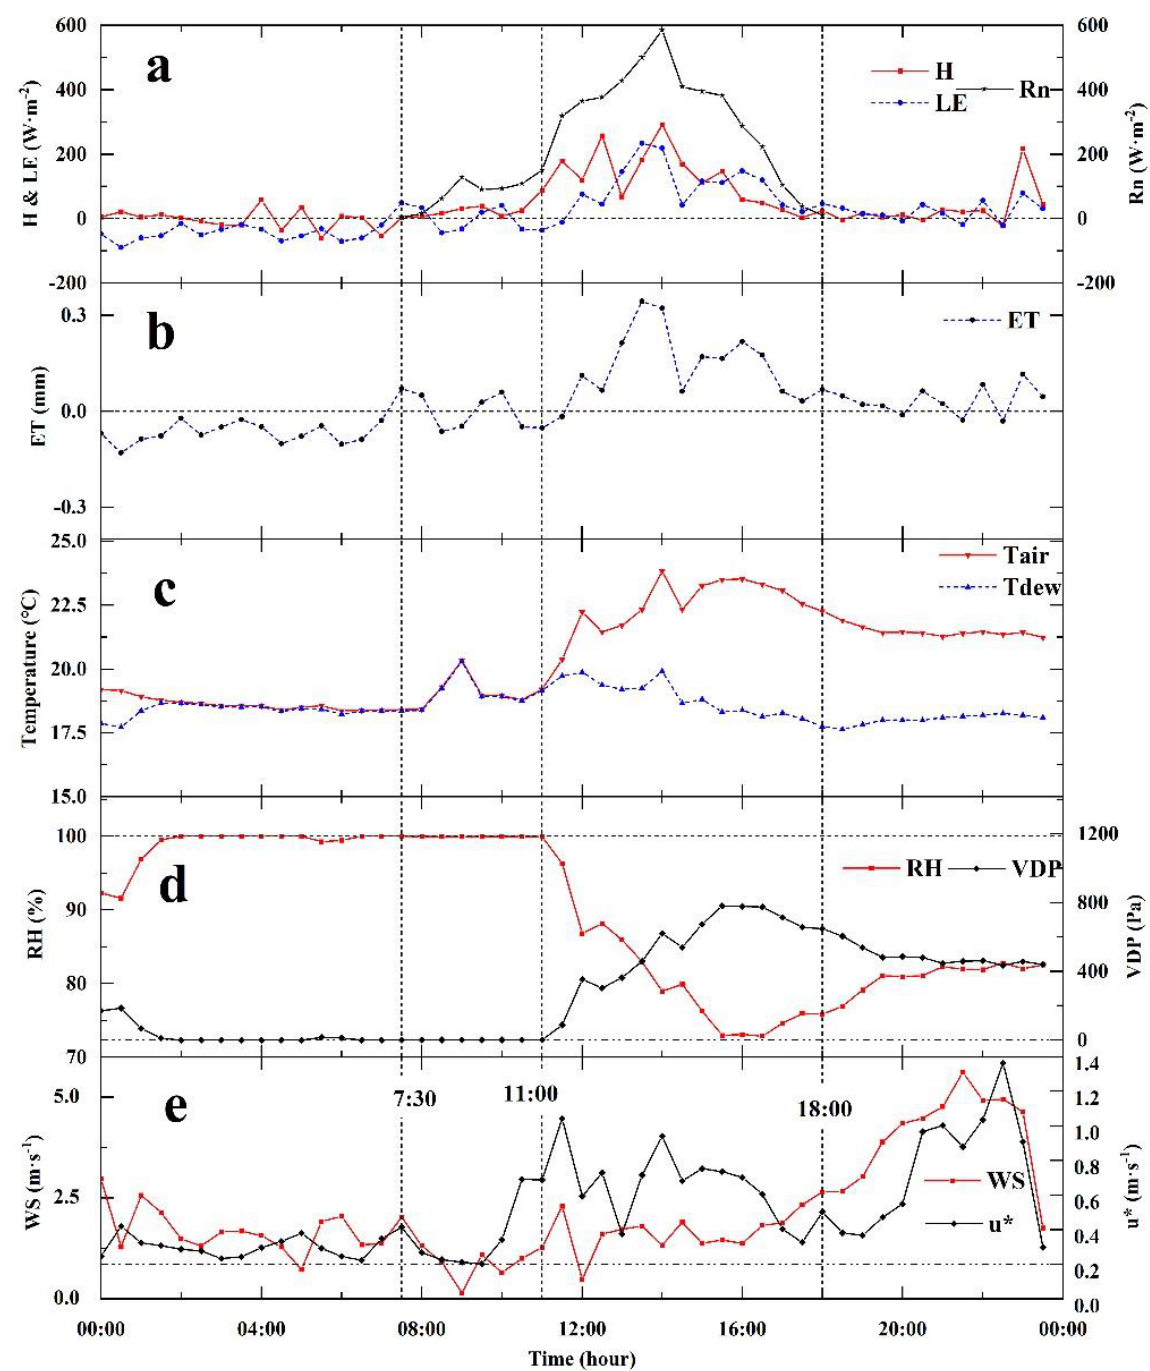
Figure 12. Intraday changes of FEs and environmental factors during fog on 22 October 2016. ( a,b ) Intraday changes of FEs during fog day. ( c − e ) Intraday changes of environmental factors during fog day: ( a ) H represents sensible heat flux, LE represents latent heat flux, Rn represents net radiation, ( b ) ET represents evapotranspiration, ( c ) Tair represents air temperature, Tdew represents dew point temperature, ( d ) RH represents relative humidity, VPD represents vapor pressure deficit, ( e ) WS represents wind speed, and u* represents friction wind speed.